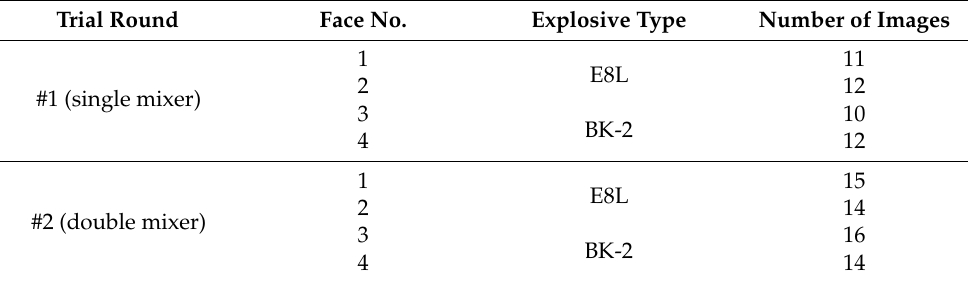
Table 2. Summary of images used for fragmentation analysis. Trial Round Face No. Explosive Type Number of Images 1 #1 (single mixer)